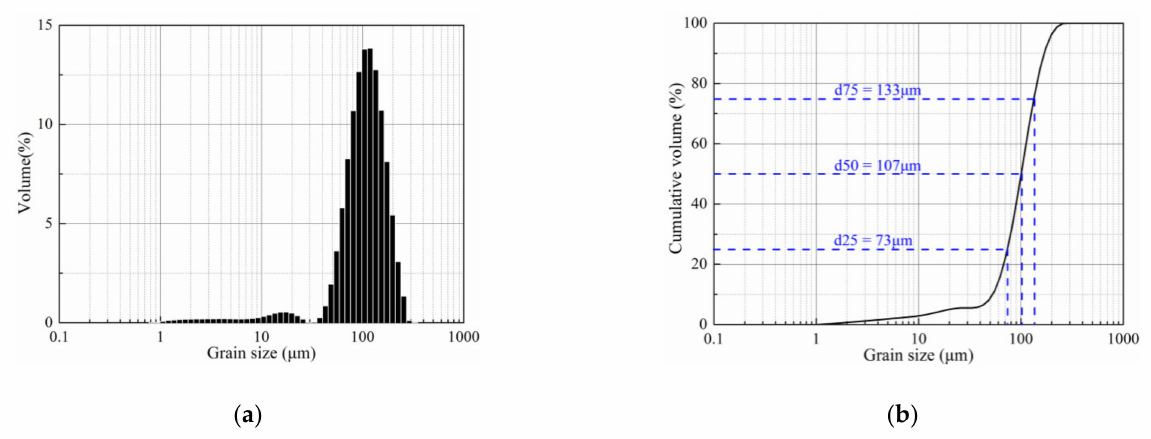
Figure 3. Sediment particle distribution: ( a ) histogram; and ( b ) cumulative size